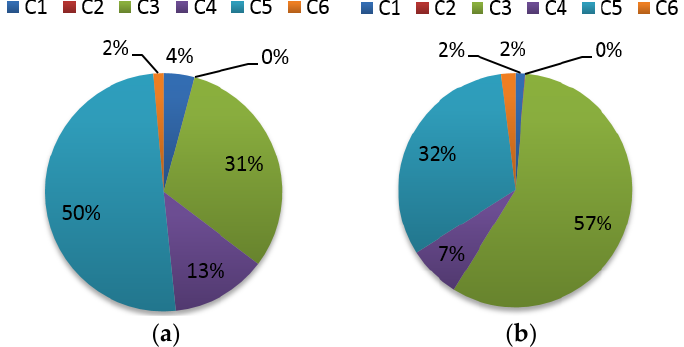
Figure 13. Percentage of the total costs for ( a ) the single floating offshore wind turbine and ( b ) the farm of 21 floating offshore wind turbines.